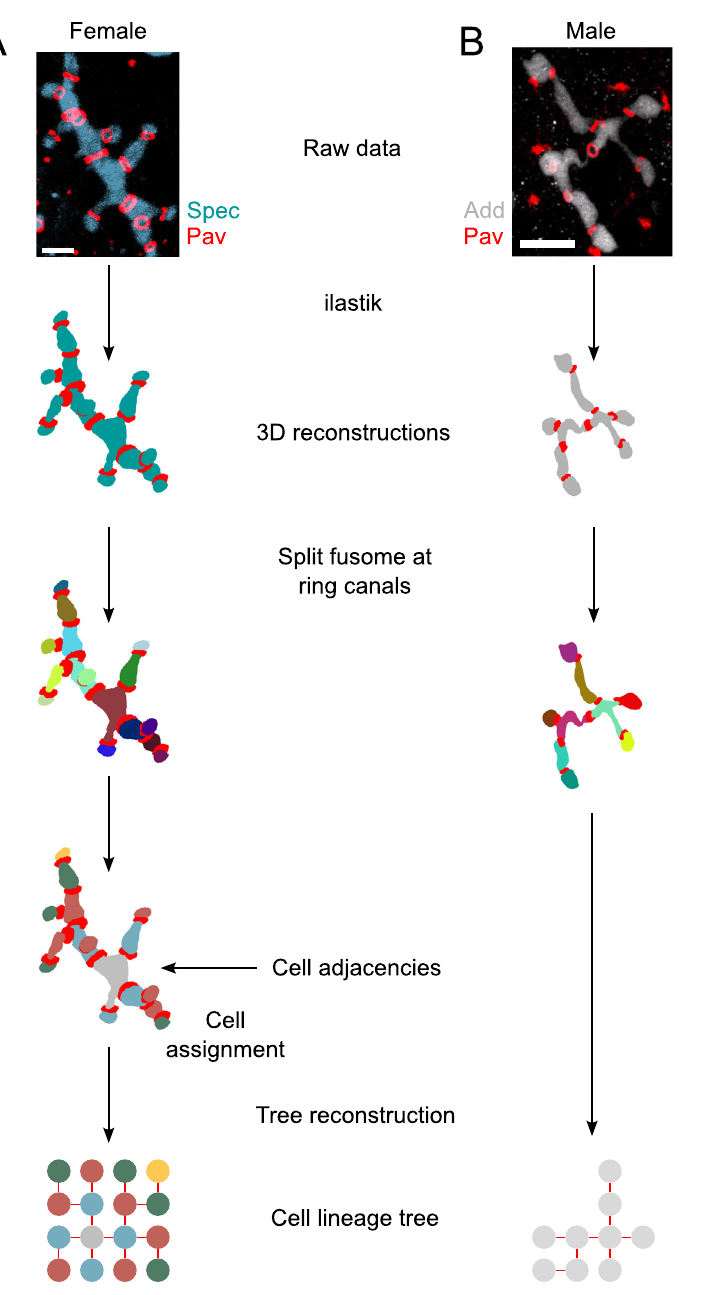
Fig 2. Pipeline for 3D fusome reconstructions in developing germline cysts. (A) Starting from 3D confocal images of fusomes with fluorescently-labeled ring canals and fusome, training in a machine learning program and processing in MATLAB as described in [44, 45] produced a 3D reconstruction of the fusome and ring canal system at successive stages of germline cyst formation (Fig 1A). From here, ring canals at the junction between sister cells were used to segment the fusome into its component parts (multicolored cells) and, in the case of oogenesis, produce an adjacency matrix representing intercellular connections within the cyst to compare with the known female germline cyst network topology, permitting unambiguous cell label assignments to the individual fusome fragments. These fusome fragments were then labeled according to their position relative to the presumptive oocyte. (B) Male cysts underwent the same procedure of collective adjacency information, but as no oocyte is present, no distinction was made between cells. Scale bars = 2 μ m (A) and 10 μ m (B).